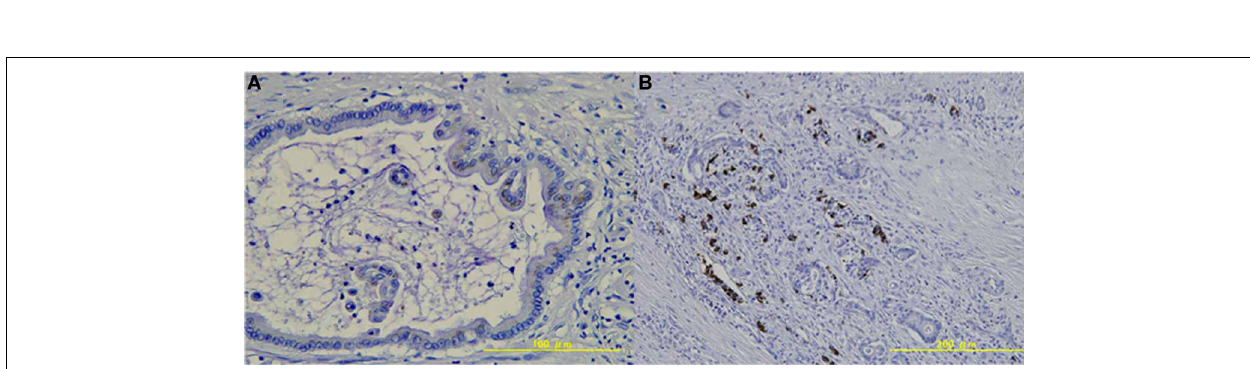
FIGURE 1 | Expression of CD133 in pancreatic tissue. (A) Pancreatic cancer cells were negative for CD133. (B) CD133 was expressed at the apical membrane of the small pancreatic duct cells in the non-neoplastic tissue (arrows).